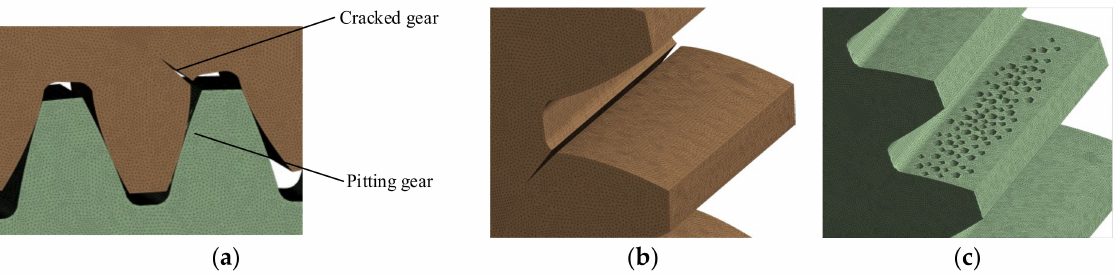
Figure 14. Fault gear meshing: ( a ) Meshing gear pair; ( b ) Gear with crack; ( c ) Gear with pitting.